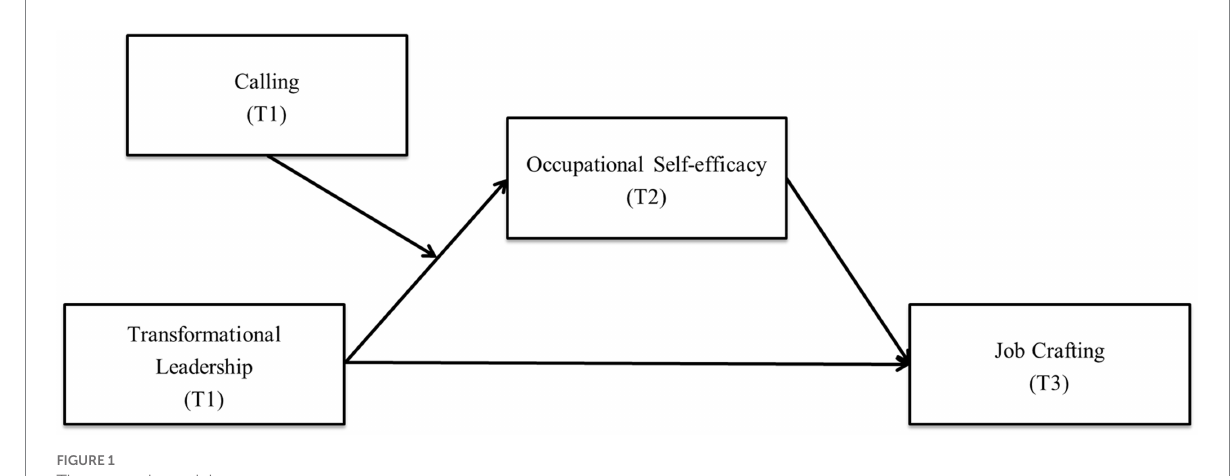
FIGURE 1 The research